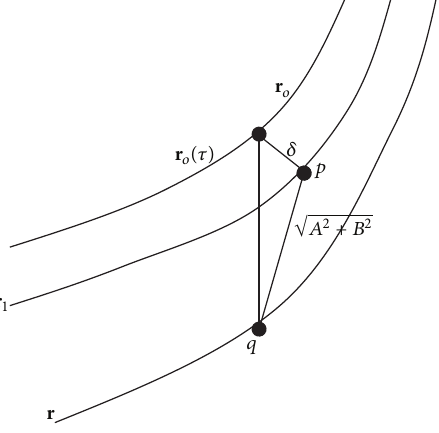
Figure 2: Topological property of the